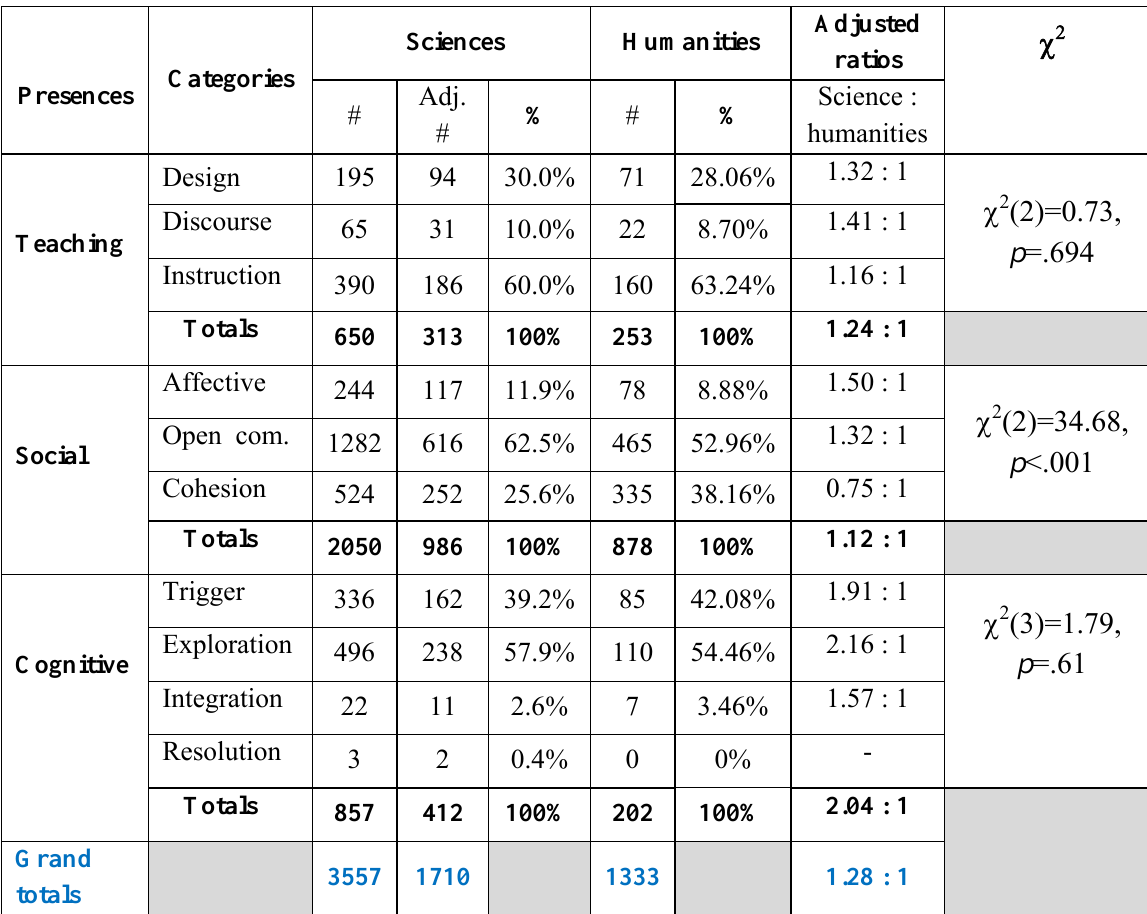
Table 7 Teaching, Social, and Cognitive Presence by Categories: Instructors and